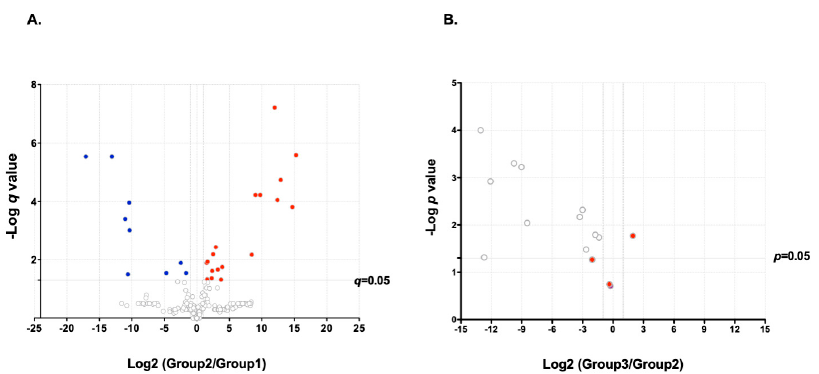
Figure 2. Volcano plots showing di ff erential proteins expression. ( A ) Group 1 versus Group 2. Red dots: proteins upregulated in Group 2. Blue dots: proteins downregulated in Group 2. Selection criteria were (i) that abundance should di ff er by at least twofold in Groups 2 and 1 and that (ii) di ff erences in abundance should be significant at the 0.05 level in a t-test adjusted for a 5% FDR after multiple testing ( q -value < 0.05). ( B ) Group 3 versus Group 2. Red dots: proteins showing statistically indistinguishable or greater expression level in Group 3 compared to Group 2. Only proteins that were measurable in all 6 samples were used for this comparison. A List of all proteins is available from Table S2.